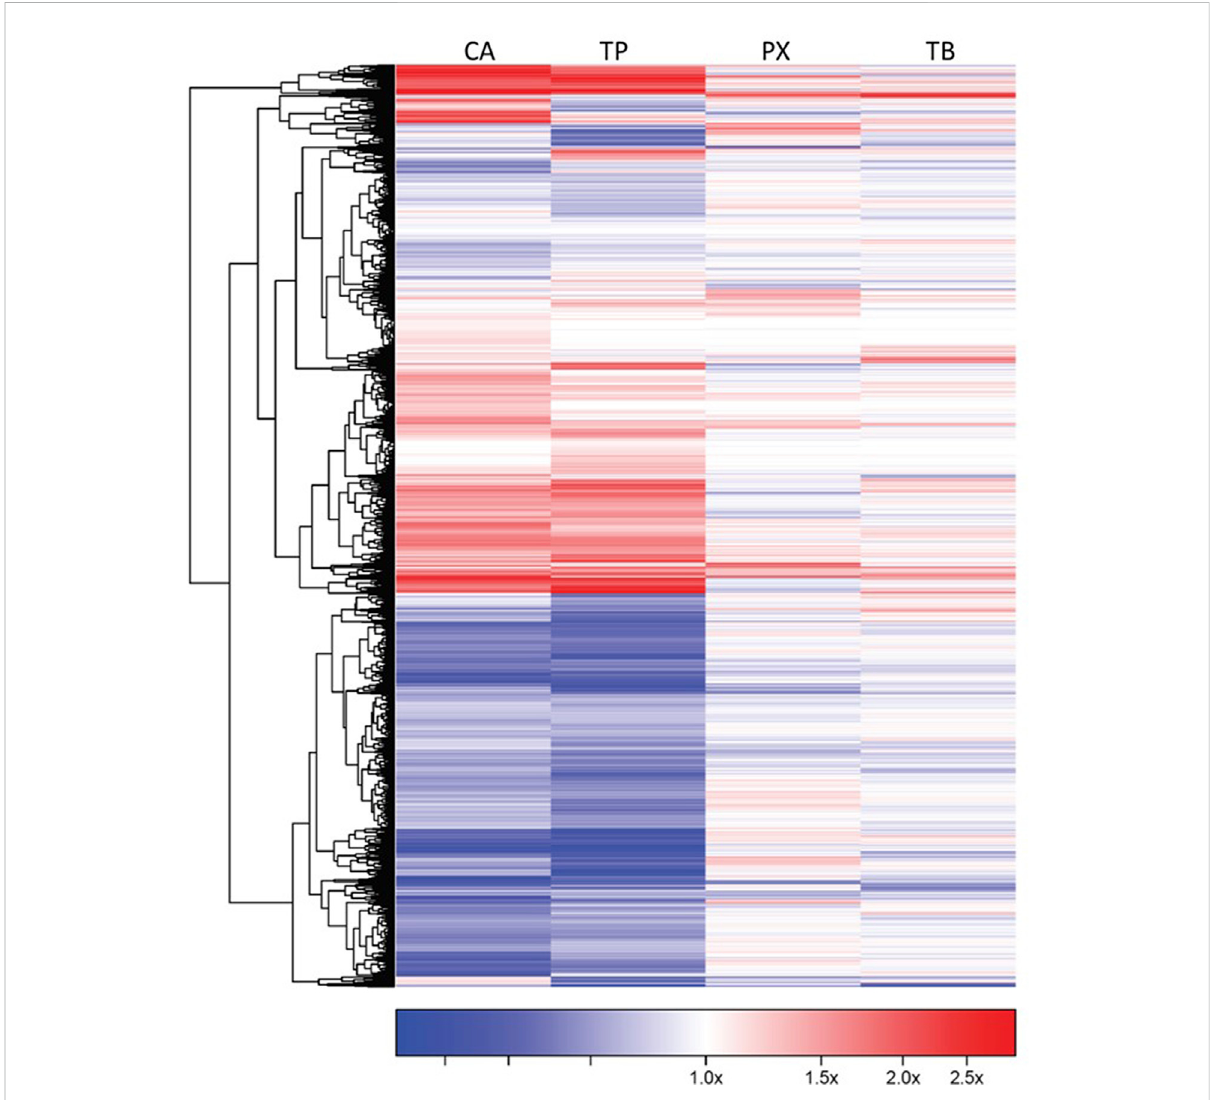
FIGURE 3 Geneexpression pro fi leofiCell-Cardiomyocytes exposed toCA,TP, PXorTB(1,000 μ M).Thegenesshowingarobustresponseafter exposure to each methylxanthine (FDR < 0.05 and at least 1.2 fold change, up- or down-regulated) are shown in this diagram. Each cell is represented as a color-coded rectangle in which the color indicates the expression value (fold change) of unaffected (white), up-regulated (red) or down-regulated (blue)genes.The hierarchical clustering andthepositioninghas beenestablishedaccordingto thesimilarityinresponse ofthese genesto each chemical evaluated. The length of thelinesinthe treeindicatesthesimilarityinregulatory patternfor each gene, with shorter length indicating more